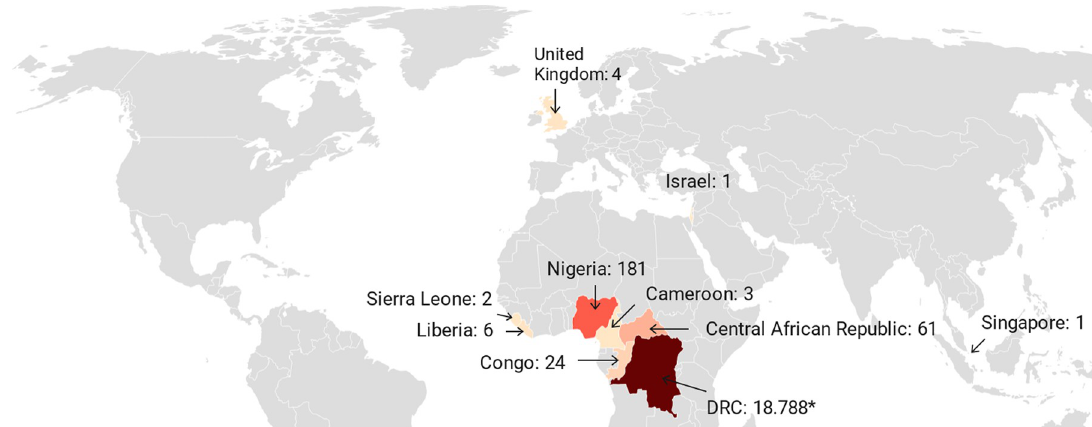
Fig 6. Number of confirmed, probable, and/or possible monkeypox cases between 2010–2019. [7,8,15,18,29,30,32,33,35,47–49,55– 57,59–67,72–74] � Number reflects suspected cases, since as of the year 2000, the number of suspected cases was primarily reported by the DRC. (base layer of the map: https://datawrapper.dwcdn.net/UUYbg/1/).